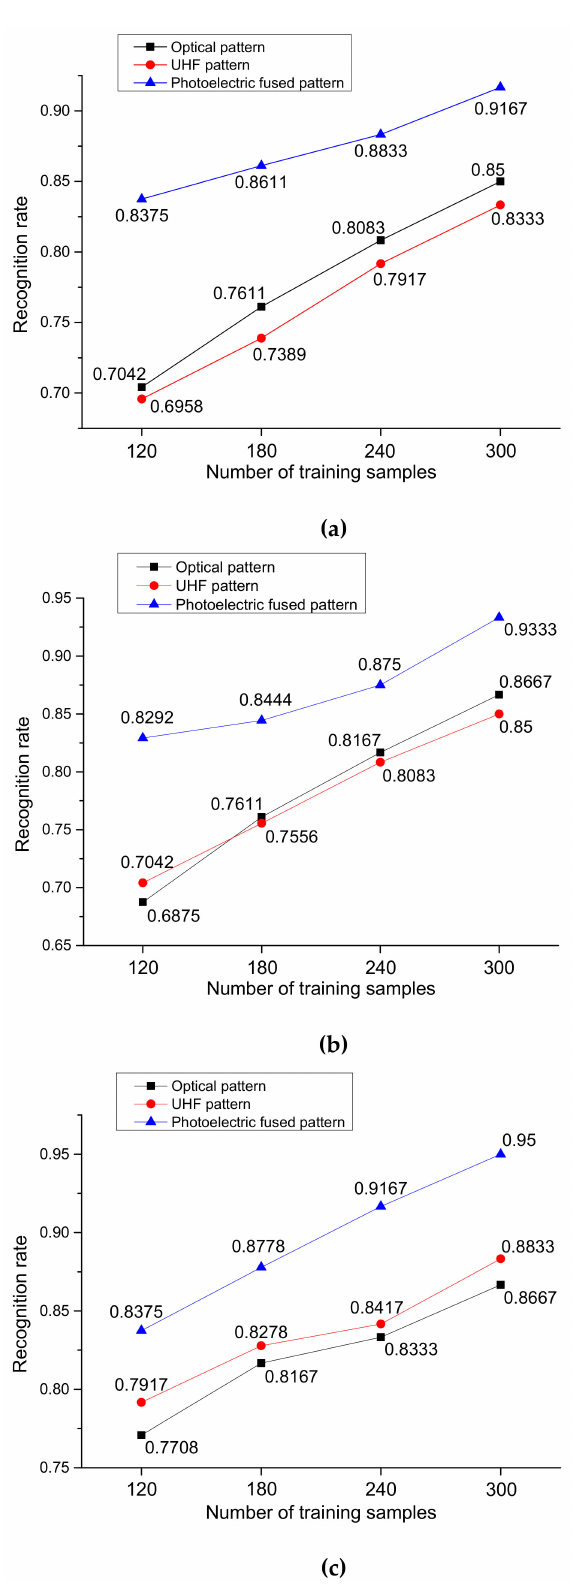
Figure 16. Recognition results of di ff erent classifiers. ( a ) linear discriminant analysis (LDA) classifier, ( b ) k-nearest neighbor (KNN) classifier, and ( c ) support vector machine (SVM)